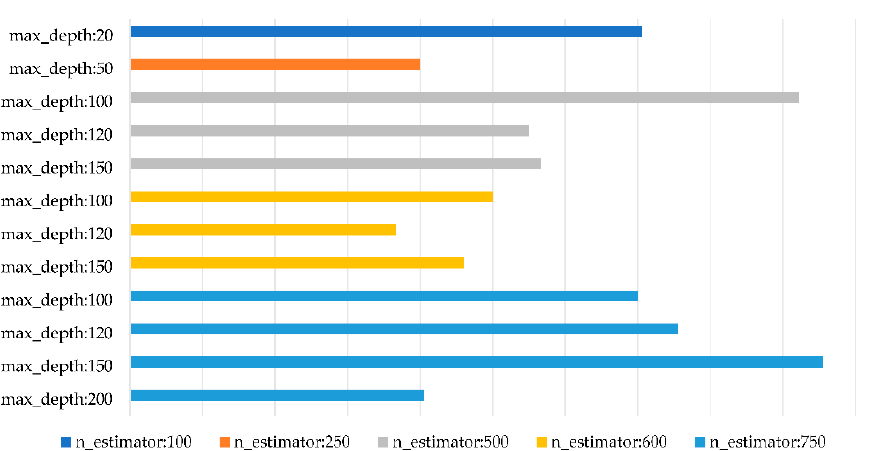
Figure 14. Test set classification accuracy of ExtraTreesClassifier with different sizes.